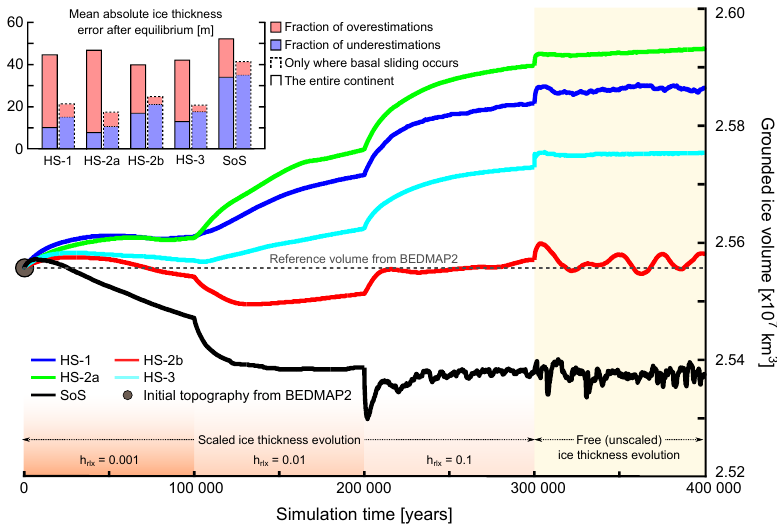
Figure 2. Overview of the calibration procedure. Main: the evolution of the total grounded ice volume during the calibration procedure, in × 10 7 km 3 . At the end of each 100kyr stage, the relaxation coefficient h rlx increases by 1 order of magnitude, from 0.001 in the first stage to 1 (free evolution), until a dynamic equilibrium is attained. Inset: mean absolute differences between the modelled and observed ice thickness at the end of the simulations, in metres. For each scheme, a mean absolute error is calculated for the entire ice sheet (left bars) and separately over the areas where basal sliding is identified (right bars). Fractions of the mean absolute error arising from under- and overestimations are shown in blue and pink,